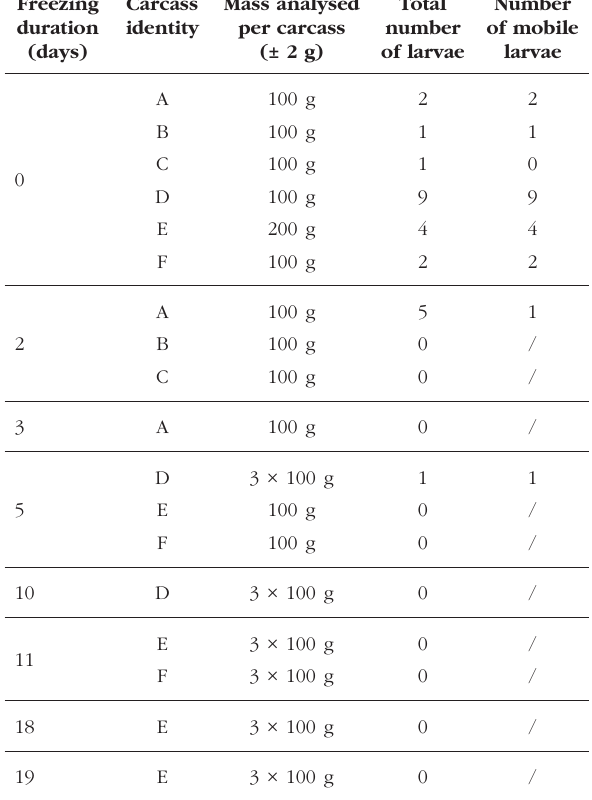
Table I. – Analysis of the cryo-resistance of Alaria alata mesocerca- riae in muscle samples from six positive wild boars’